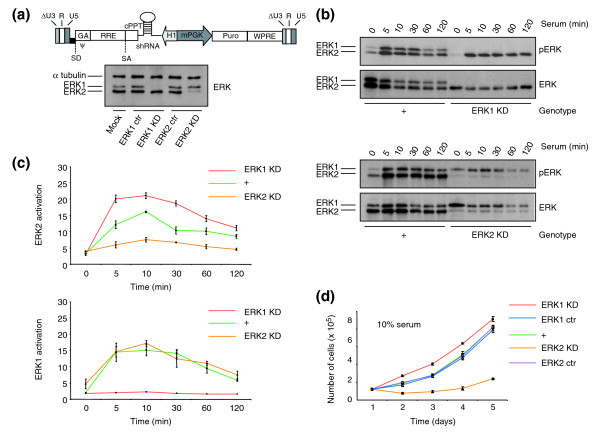
ERK-specific gene silencing unmasks differential roles for ERK1 and ERK2 in cell signaling and proliferation. (a) Schematic representation (top) of the proviral vector form used in shRNA-mediated RNA interference. ΔU3, R and U5 constitute a chimeric long terminal repeat (LTR) of the HIV-1 5' LTR with a deletion in U3 abolishing LTR mediated transcription; SD and SA, splice donor and acceptor sites; ψ encapsidation signal including the 5' portion of the gag gene (GA); RRE, Rev-response element; cPPT, central polypurine tract; shRNA, small hairpin RNA; H1, human H1 promoter; mPGK, mouse phosphoglycerate kinase promoter; Puro, puromycin-resistance gene; WPRE, woodchuck hepatitis virus post-transcription regulatory element. The western blot (bottom) shows expression levels of ERK proteins in wild-type MEFs transduced with equal amounts of lentiviral vectors carrying the indicated knock-down (KD) shRNA cassette or the corresponding control sequence (ctr). α-tubulin was used as a loading control. (b) Wild type (+), ERK1 KD or ERK2 KD MEFs were serum starved for 24 h and then stimulated with 20% serum for 5, 10, 30, 60 and 120 min. Western blots were analyzed with anti-phospho-ERK and anti-ERK antibodies, as in Figure 1. (c) Bands from (b) were quantified and fold increases in phospho-ERK2 or phospho-ERK1 levels over total ERK2 or total ERK1 levels calculated. Mean ± SEM of three experiments is indicated. (d) Growth curve of wild-type, ERK1 and ERK2 KD fibroblasts and their corresponding controls, seeded in triplicate in the presence of 10% serum and 2 μg/ml puromycin and counted after the indicated times. The data are the mean of three independent experiments ± SEM.